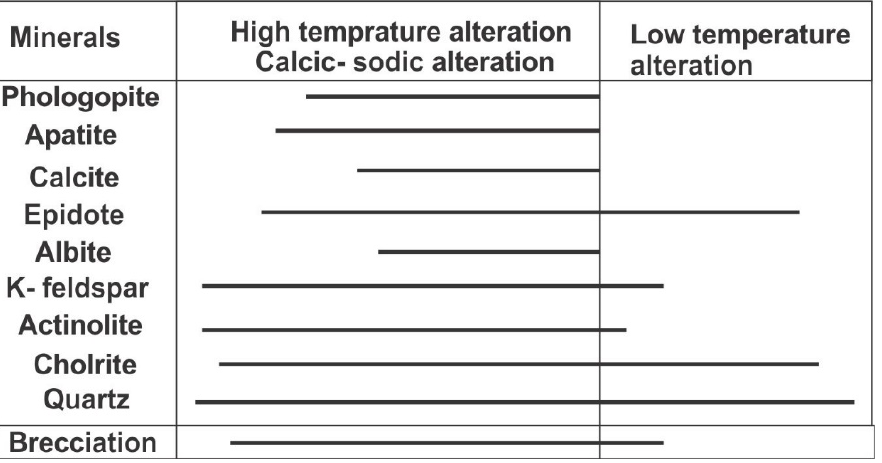
Figure 4. Mineral paragenesis of Ghareh Bagh mica mine.